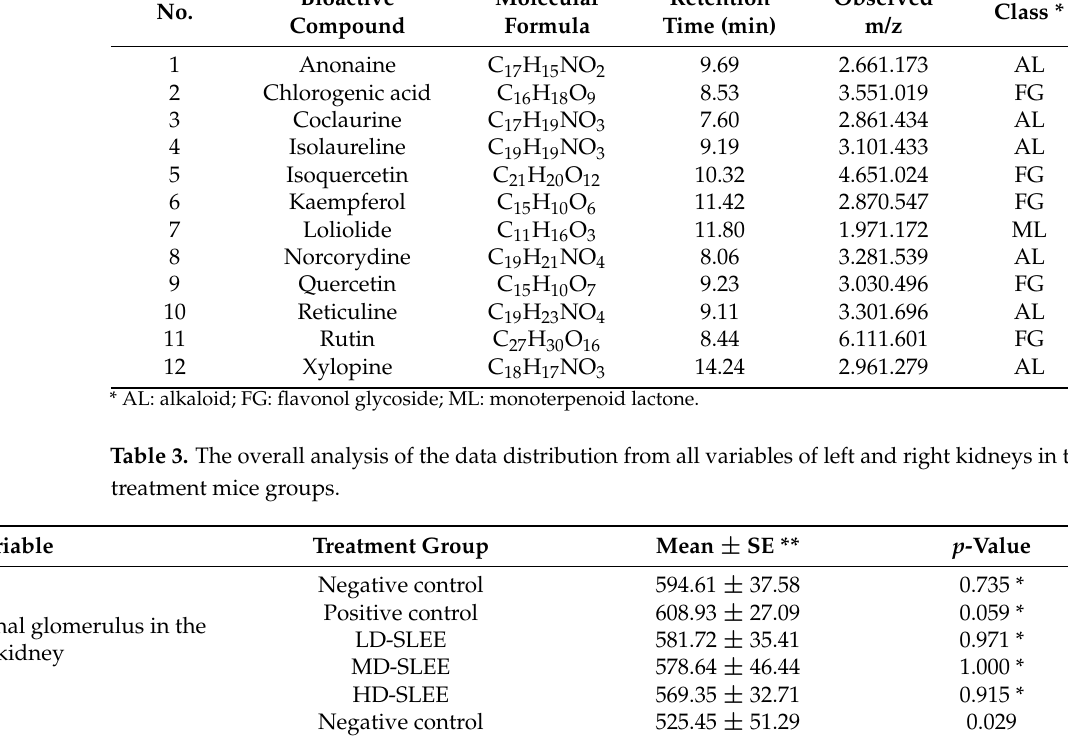
Figure 2. Chromatogram profile of bioactive compounds from A. muricata leaf ethanol extract using LC-MS/MS analysis. Table 2. Bioactive compound profiles from A. muricata leaf ethanol extracts identified by LC-MS/MS.